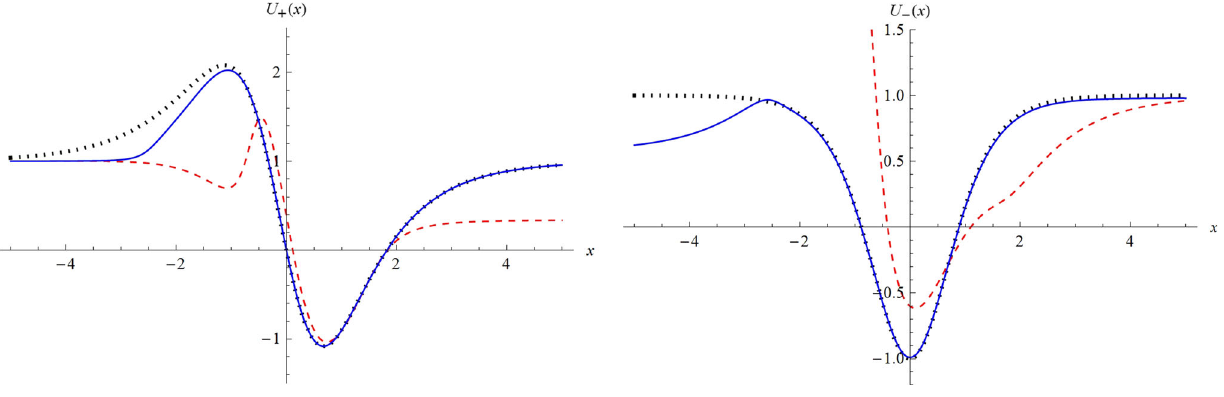
Fig. 7 Quantum-mechanical potentials U + (on the left) and U − (on the right) for a 2 = 0 and α = 1. For both, we have plotted the values b 3 = 0, b 3 = 0 . 01, and b 3 = 0 . 4, depicted with dotted, solid, and dashed lines,